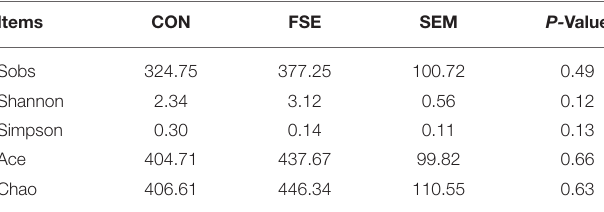
TABLE 5 | Effects of maternal dietary Forsythia suspensa extract supplementation on α -diversity in cecum and colon microbiota of fecal microbiota of